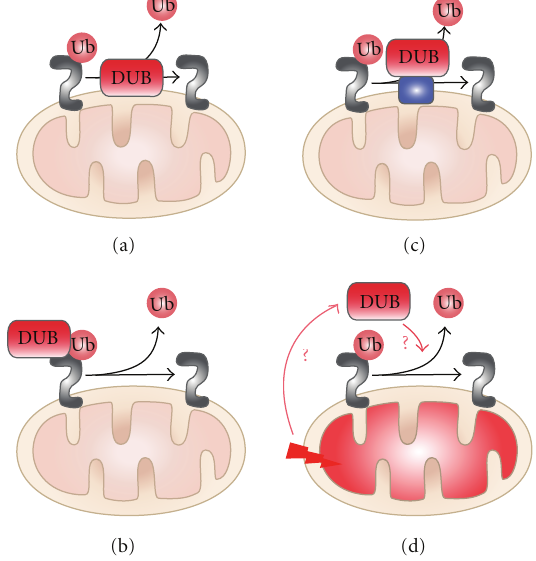
Figure 2: Potential mechanisms to direct deubiquitination at the mitochondria. The diagram illustrates the multiple ways in which DUBs may function at the mitochondria. (a) DUBs such as USP30 can reside in the OMM, in an orientation that provides access to ubiquitin-modified OMM proteins. (b) Substrate-specific DUBs, like USP9x and ataxin-3, might be directly recruited to the mitochondria by their substrates, Mcl1 and Parkin, respectively. (c) It is also possible that DUBs are a ffi xed at the membrane through protein interactions with nonsubstrate proteins at the OMM. This arrangement can bring deubiquitinases in close proximity to their substrates. Although DUBs that use such a mechanism have not yet been identified, the finding that most DUBs contain multiple protein-protein interaction domains lends support to this view. (d) Certain cellular conditions, such as ROS-induced stress, may recruit cytoplasmic DUBs to the mitochondria to counteract the